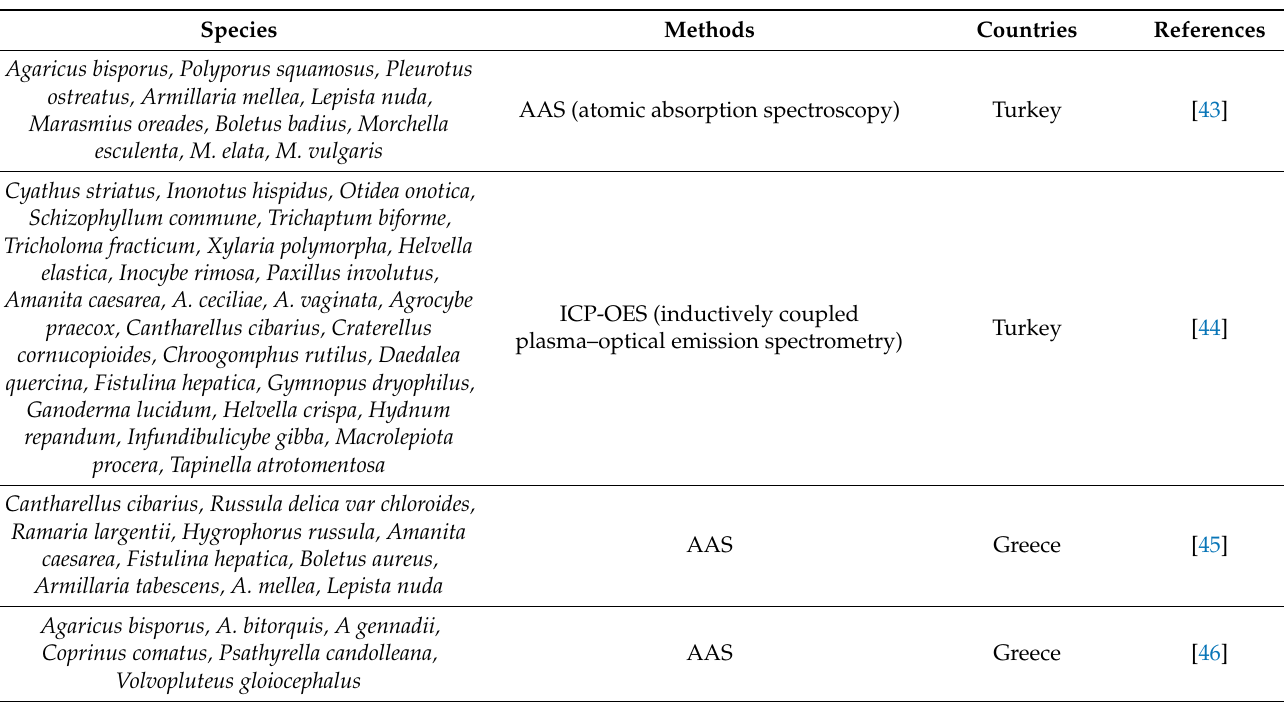
Table 2. Species, methods for determination of iron, and countries in the